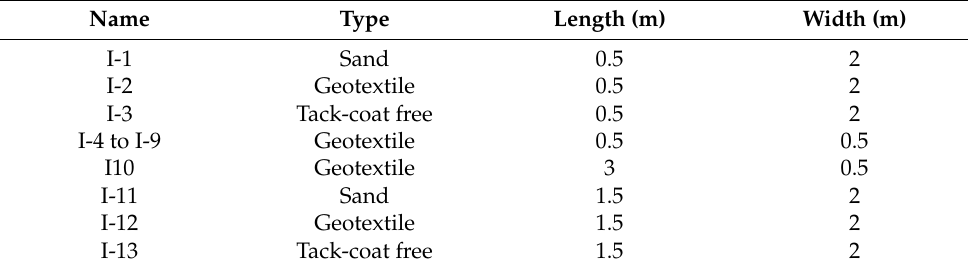
Table 1. Characteristics of the artificial defects along the test track. Figure 2. ( a ) Dual wheels of the carrousel, ( b ) Traffic density vs. lateral positions of the dual wheels per 100 K loadings.